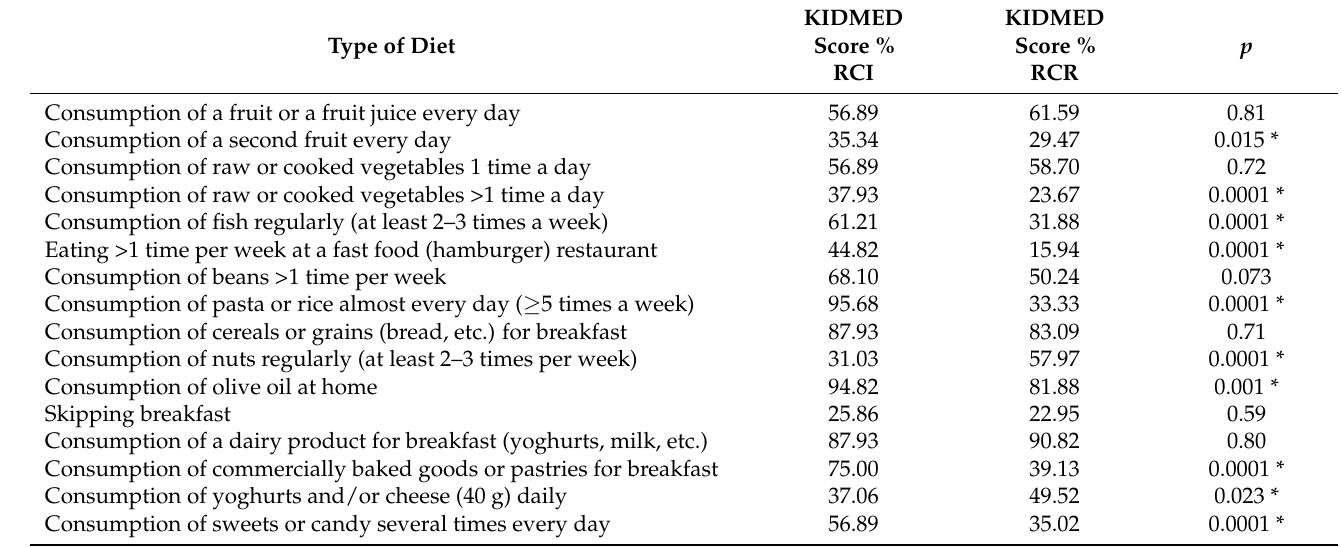
Table 3. Comparison of the KIDMED items between RCI and RCR.